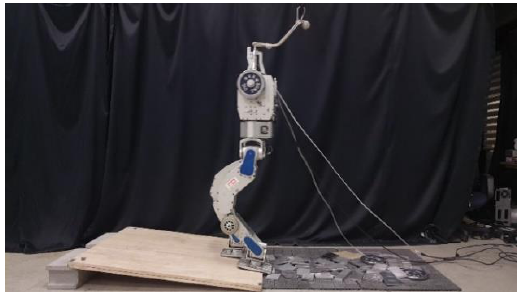
Figure 17. Snapshot of walking experiment on uneven terrain with varying local and global slopes.